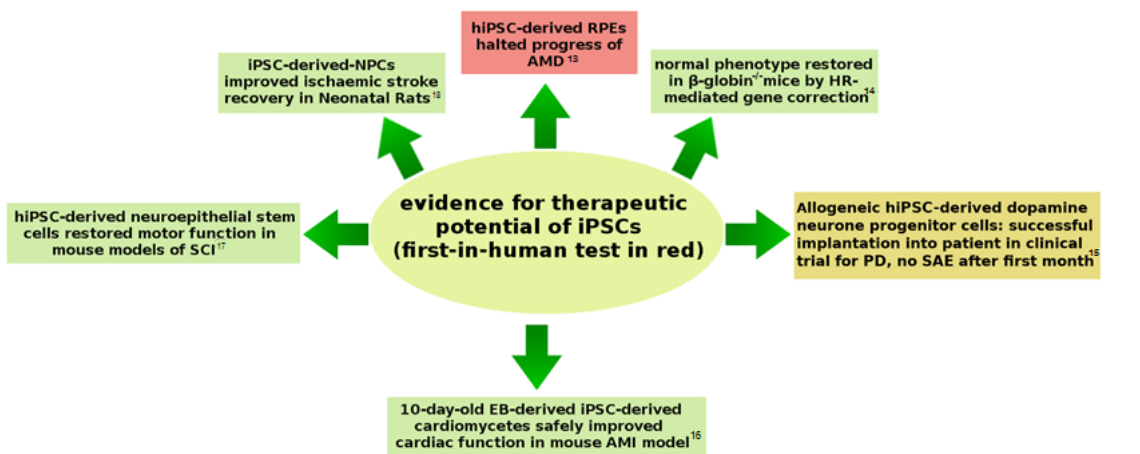
Figure 2. Evidence of the therapeutic potential of iPSC-derived stem cells in the form of two clinical and four pre-clinical studies. Abbreviations: AMD, Age-related Macular Degeneration; AMI, Acute Myocardial Infarction; EB, Embryoid Body; HR, Homologous Recombination; NPC, Neural Progenitor Cells; PD, Parkinson’s Disease; SAE, Serious Adverse Event; SCI, Spinal Cord Injury. Sources: [13–18].